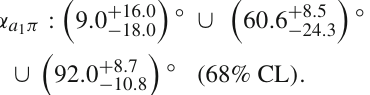
) has the same value as eff